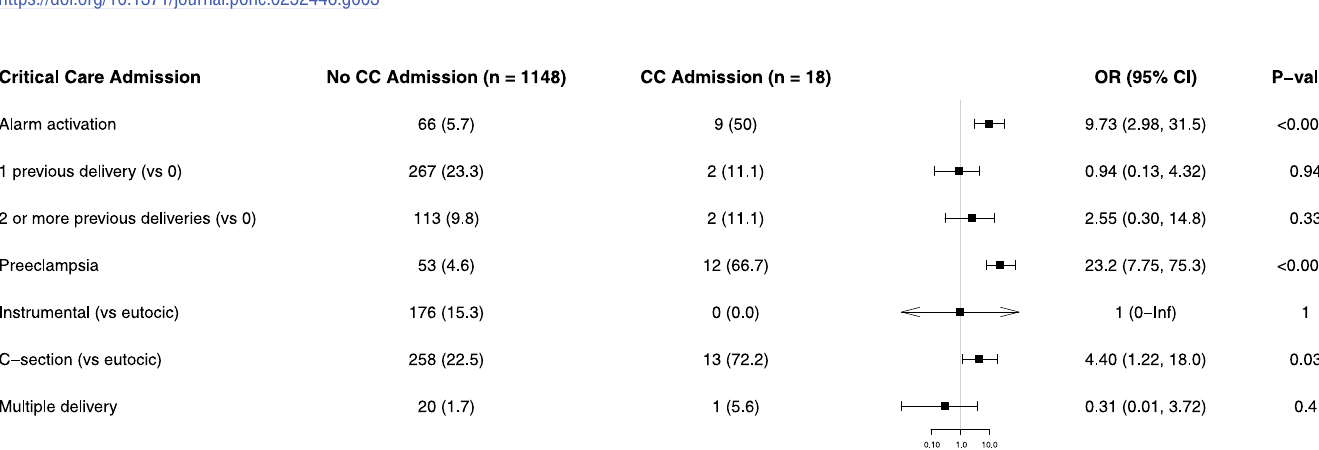
PLOS ONE | https://doi.org/10.1371/journal.pone.0252446 June 3,